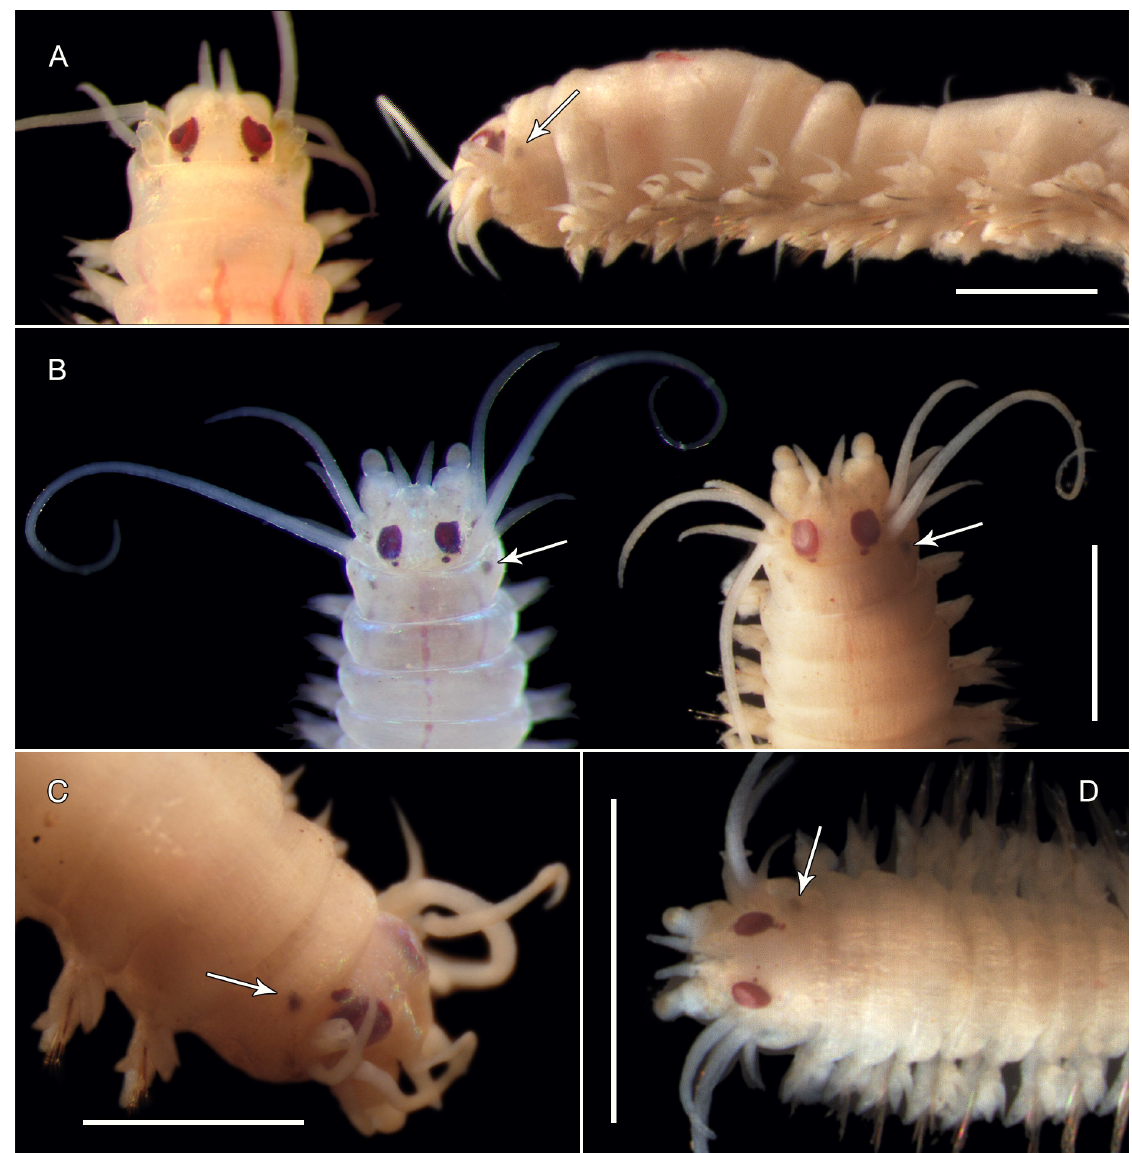
Fig. 4. Neanthes goodayi sp. nov., paratypes. A . Paratype (NHM_1624), preserved specimen; dorsal anterior view, live image (left); lateral anterior view, preserved specimen (right). B . Paratype (NHM_755); dorsal anterior view, live image (left), preserved specimen (right); arrows marking pigmentation. C . Paratype (NHM_238), dorsal anterior view, arrows mark pigmentation. D . Paratype (NHM_512), dorsal anterior view, arrows mark pigmentation. Scale bars =